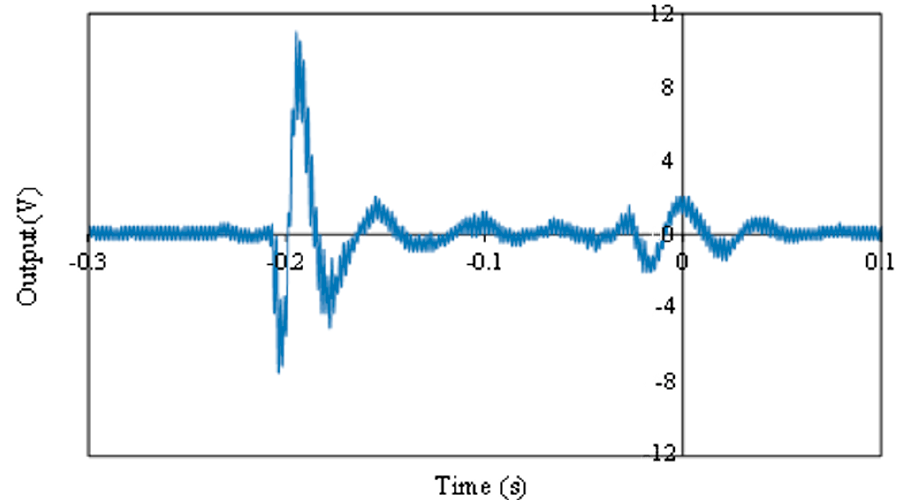
Figure 2. The experimentally obtained voltage versus time for PVDF undergoing axial